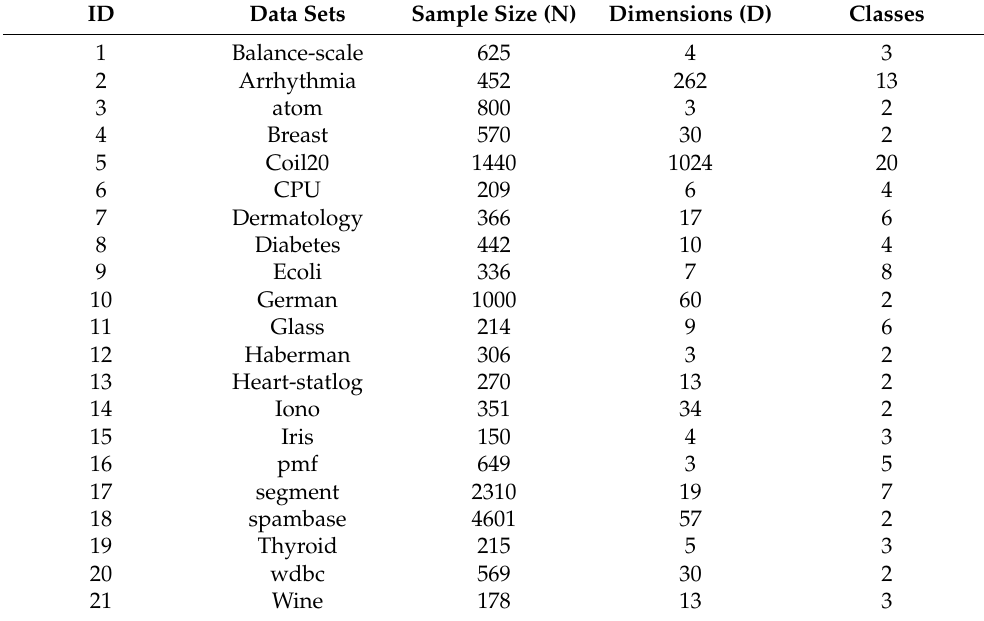
Table 1. A description of the data set used. ID Data